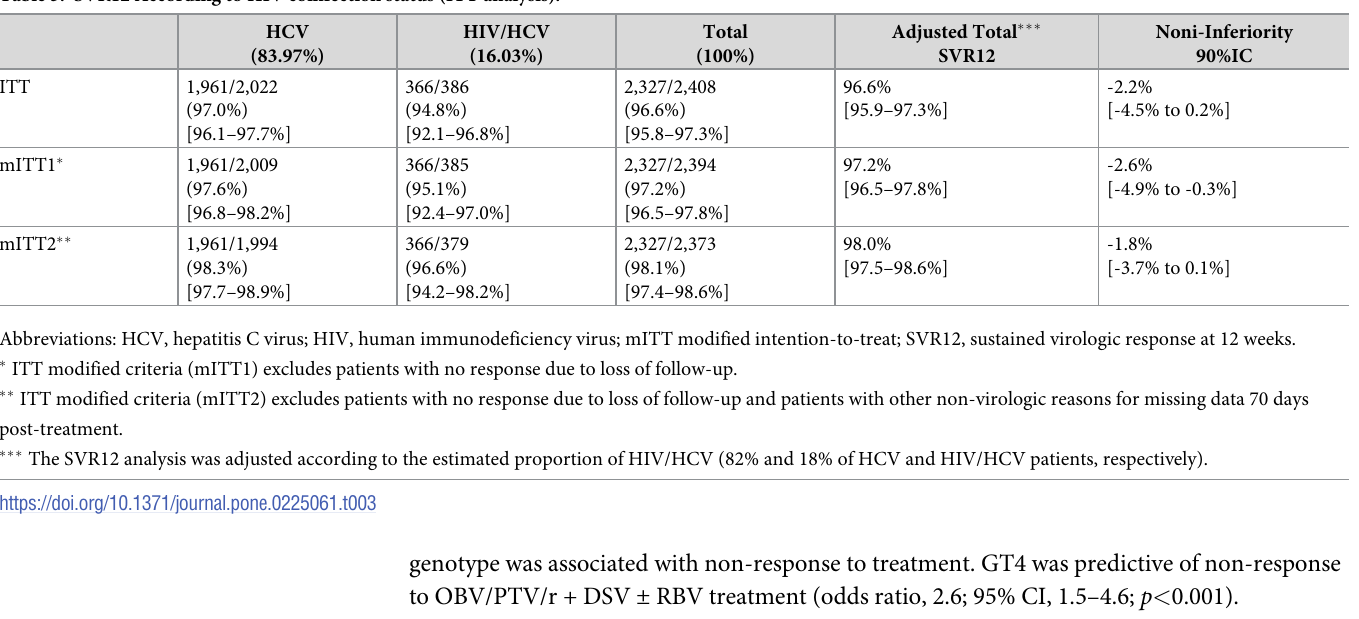
Table 3. SVR12 According to HIV coinfection status (ITT